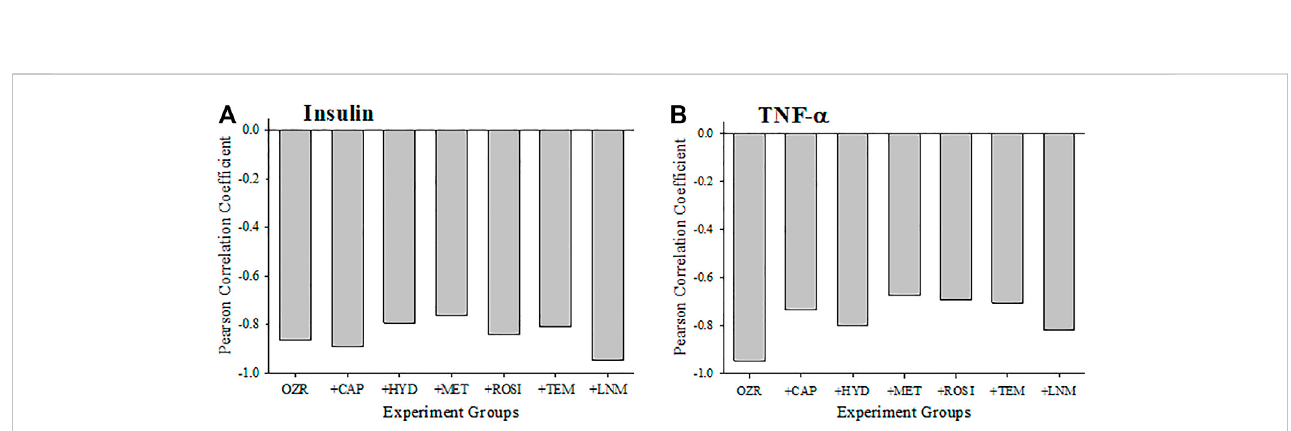
FIGURE 5 Data(mean±SE)describingthecriterionvaliditybetweenplasmainsulin (A) orTNF- α (B) andthecerebralVascularHealthIndex(VHI)acrossthedifferent treatment groups in the present study. Criterion validity is demonstrated by a strong, negative Pearson Correlation coef fi cient between insulin or TNF- α and VHI in OZR. Please see text for